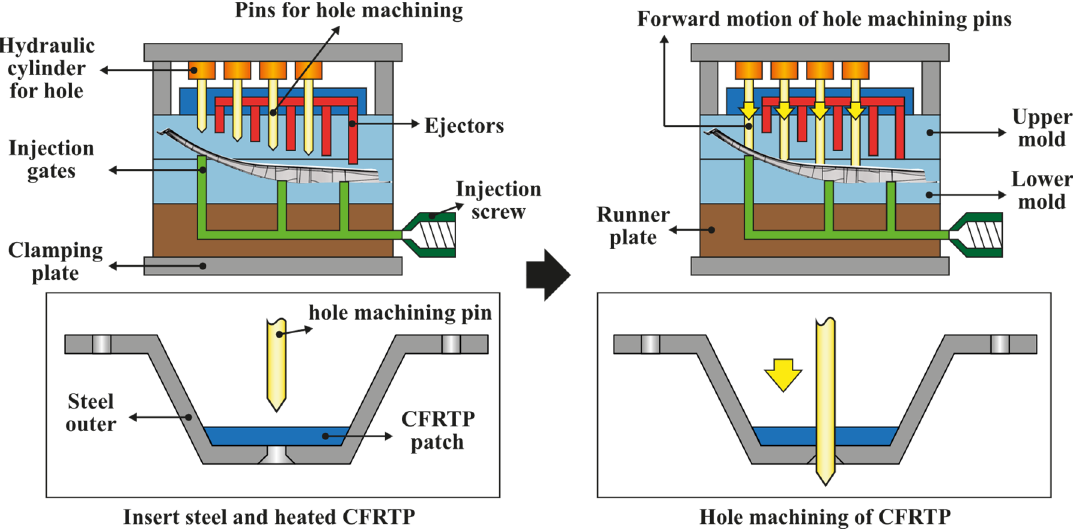
Figure 24. Design of hybrid mold structure and operation method of upper mold pins for hole machining and ejection.